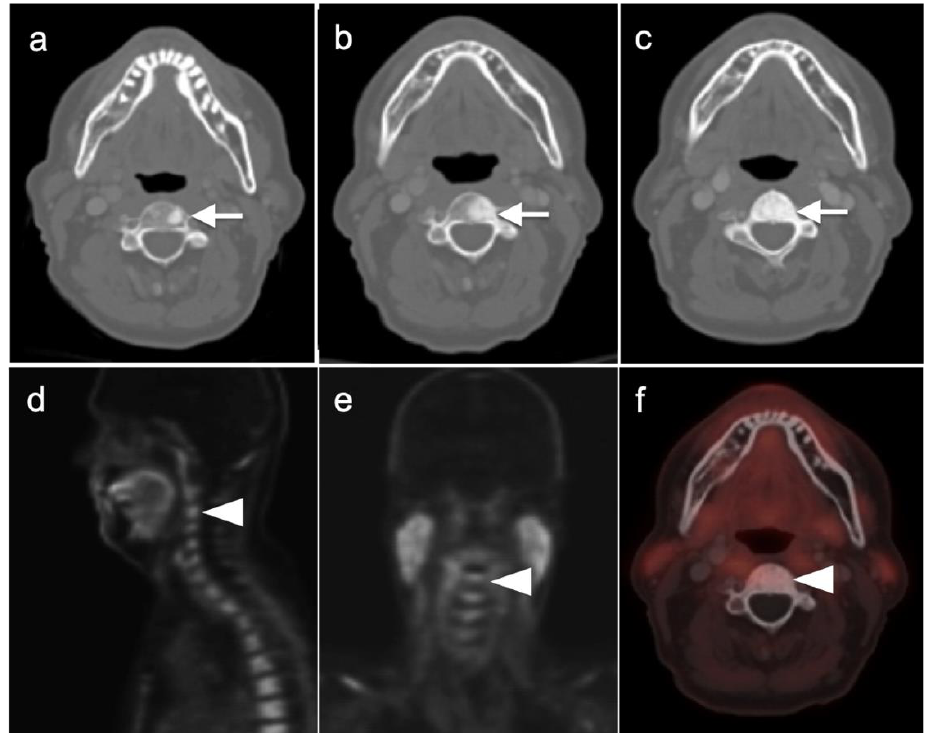
Figure 25. [ 18 F]-Fluciclovine-negative PET-CT scans in a patient with metastatic bone disease to an upper cervical vertebra. ( a – c ) There is progressive sclerosis of the vertebra in 3 successive CT scans performed with [ 18 F]-Fluciclovine PET-CT scans over a two-year interval (left to right); ( d – f ) the last 18 F-fluciclovine PET-CT scan shows no increased uptake in the bone metastasis over that of normal background marrow.